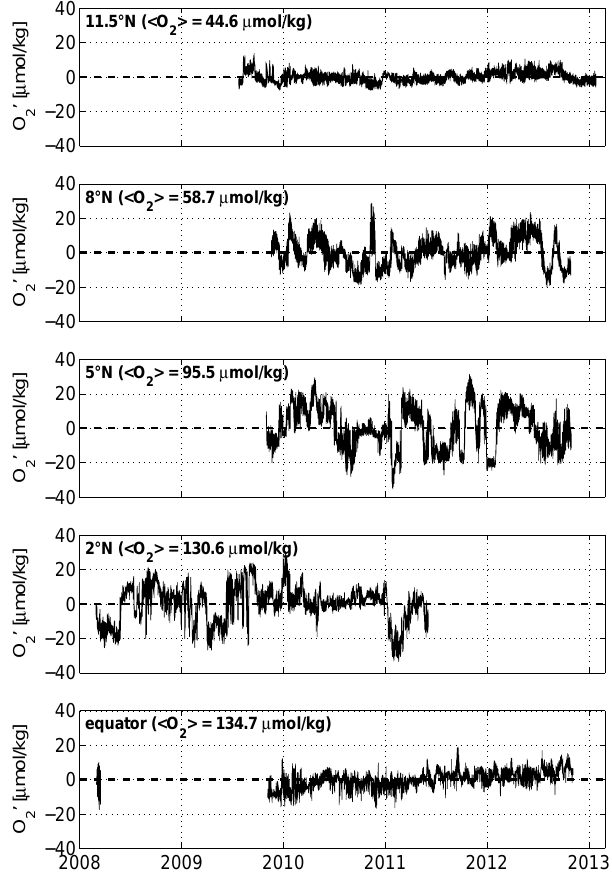
Figure 9. As Fig. 8, but at about 500m in